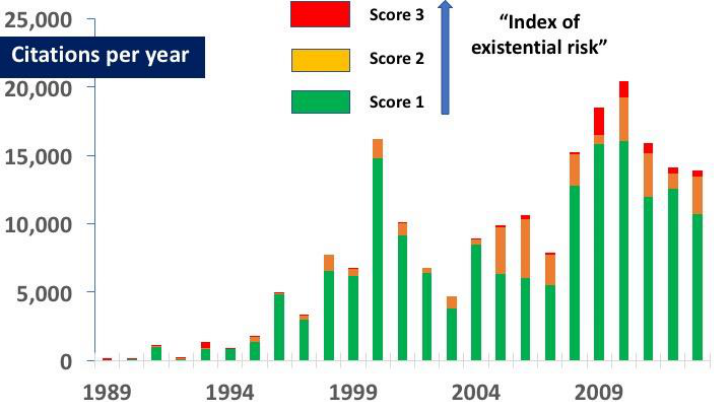
Figure 2. Number of citations per annum for each score of paper. Most citations were for papers scored as one. Note that in 2005–2007 three extensively cited papers were scored as two (these are discussed in the Appendix A).